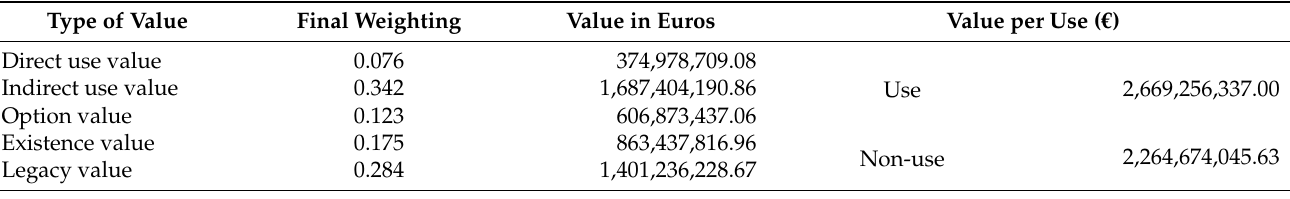
Table 5. Total economic value according to its components.